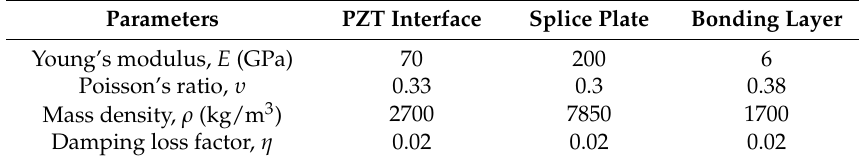
Table 1. Material properties of the splice plate, the PZT interface, and the bonding layer.